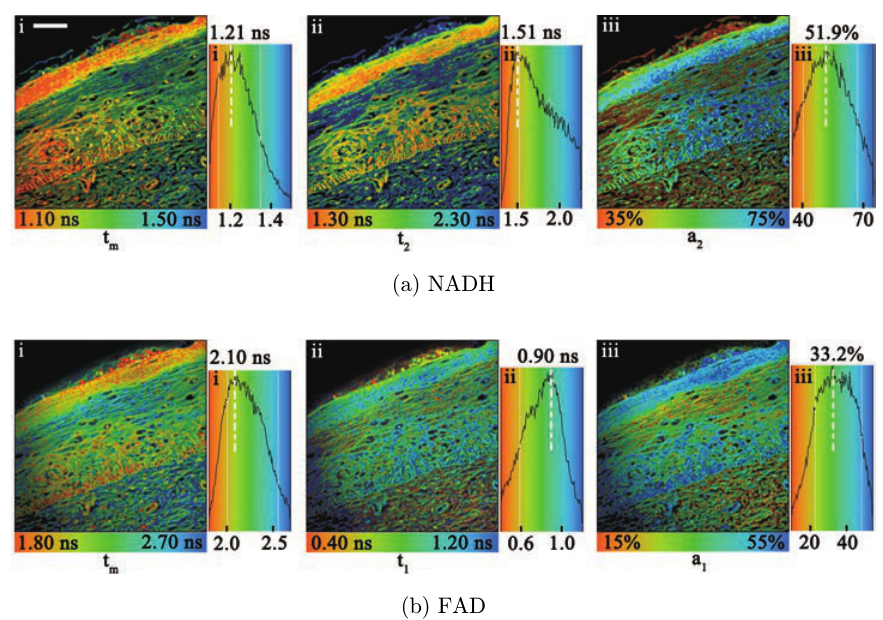
Fig. 5. (a) NAD(P)H and (b) FAD FLIM images of a cervical tissue slide and the corresponding distribution curves of the images. (i) the mean lifetime t m , (ii) the lifetime component of bound state, (iii) the fraction contribution of bound state. Scale bar: 50 (cid:1) m. The sample slide was from Patient No. 18. The images were detected by the two-channel TCSPC system.